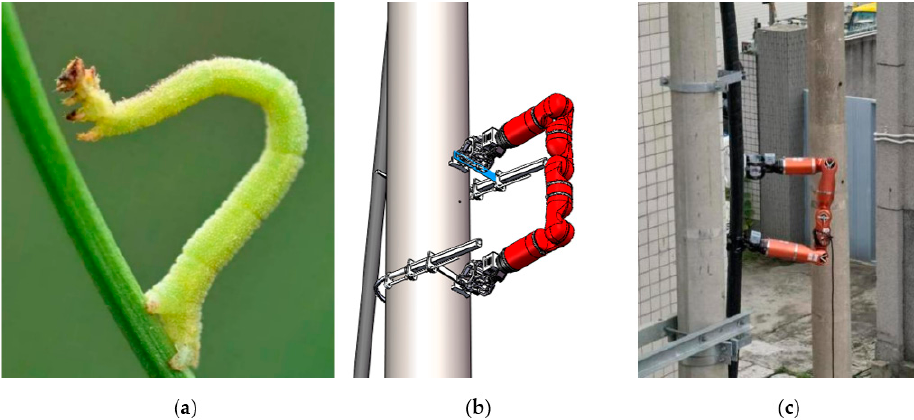
Figure 2. Biomimetics and mechanical principle of pole climbing robot. ( a ) Inchworm, ( b ) 3D rendering, ( c ) climbing robotic system.